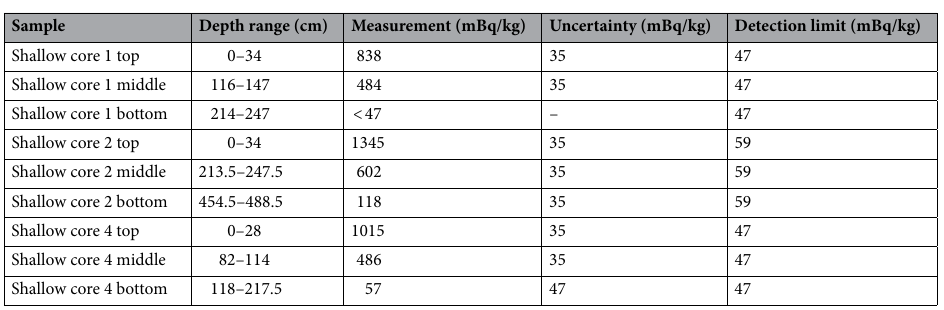
Table 3. Tritium concentrations of three shallow cores drilled at the WSS summit in 2018.